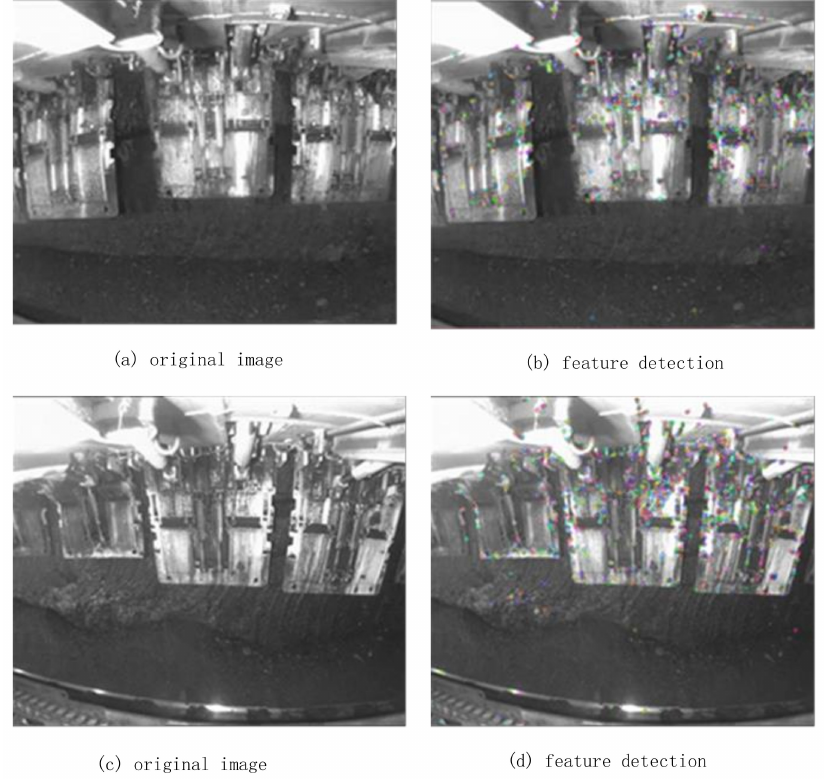
Figure 2. Results of feature point detection in coal mine underground images: ( a , c ) original images, and ( b , d ) feature detection